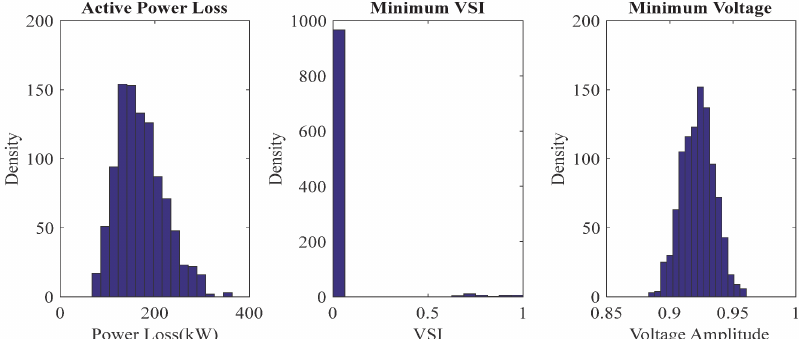
Figure 11. Stochastic evaluation of the 33-bus system with uncertainties before placement of PVs.